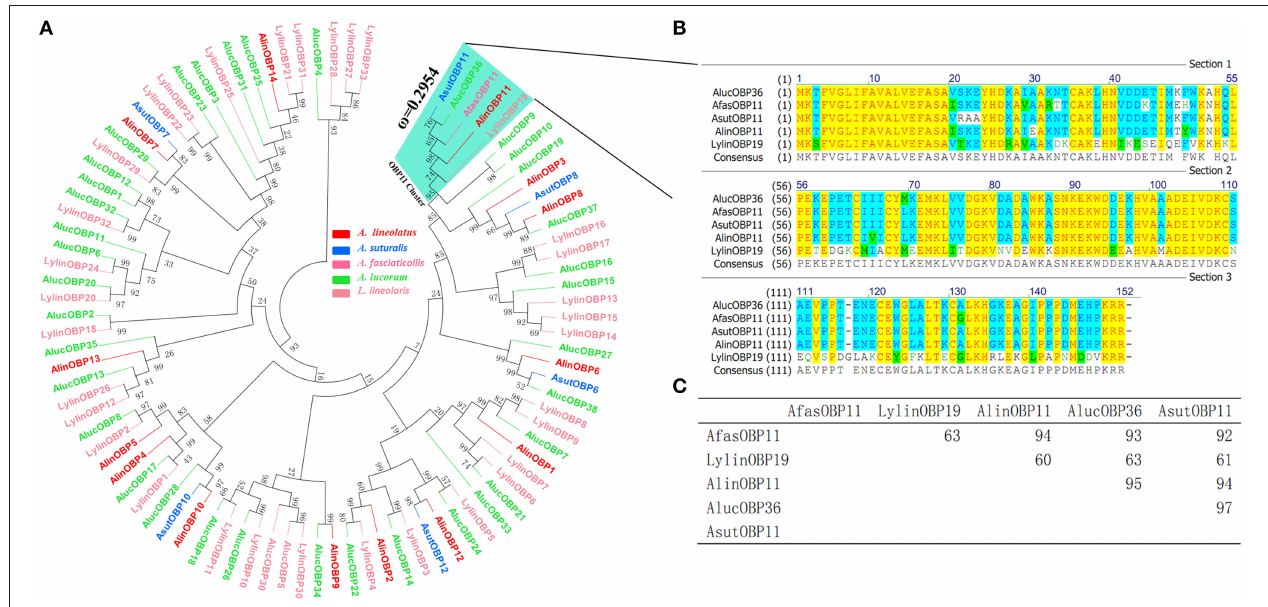
FIGURE 1 | Sequence alignment and phylogeny of AlinOBP11 with other OBPs identified in five bug species. (A) Neighbor-joining phylogenetic tree was constructed used MEGA 6.0 with a p-distance model and a pairwise deletion of gaps; The non-synonymous (dN) to synonymous (dS) substitution rate ( ω ) of OBP11 orthologs was labeled beside its cluster. (B) Sequence alignment was performed using the program ClustalX 2.1 with default gap penalty parameters of gap opening 10 and extension 0.2, and was edited using the GeneDoc 2.7.0 software. (C) The percent identity matrix of OBP11 orthologs is calculated using Vector NTI 10.0.